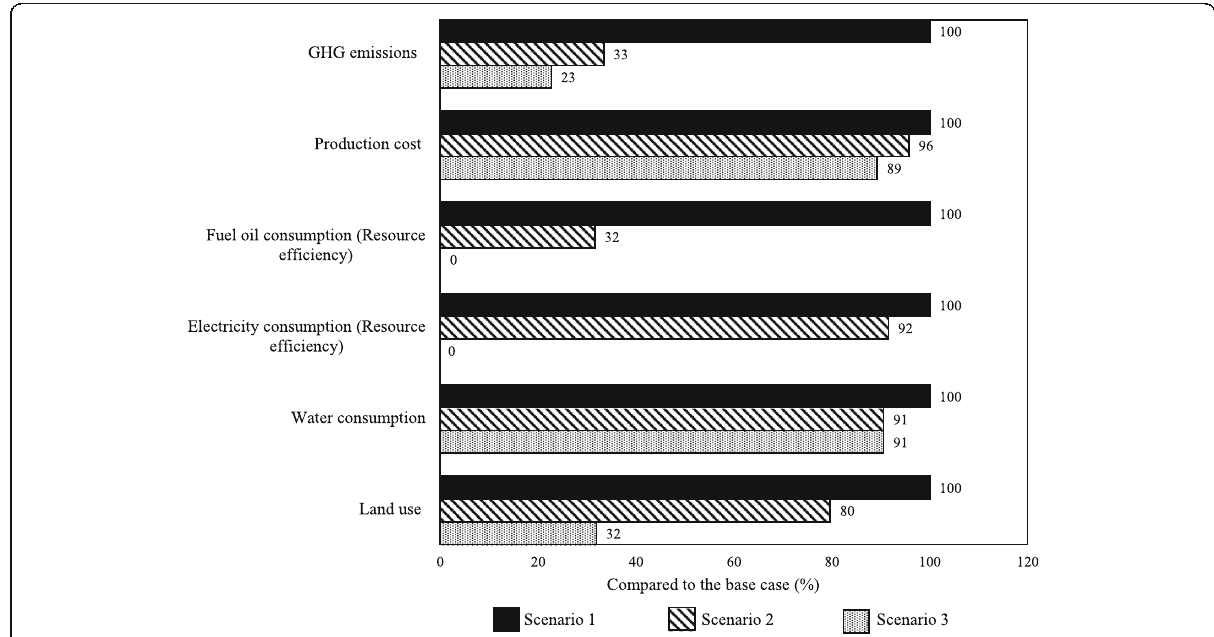
Fig. 4 Overall reduction of GHG emission, production cost, resource use, and land use from the three scenarios of starch production. Scenario 1 refers to a factory without integrated biogas system, Scenario 2 is a factory with integrated biogas installation using wastewater as a raw material, and Scenario 3 is a factory with biogas system using both wastewater and cassava pulp as raw